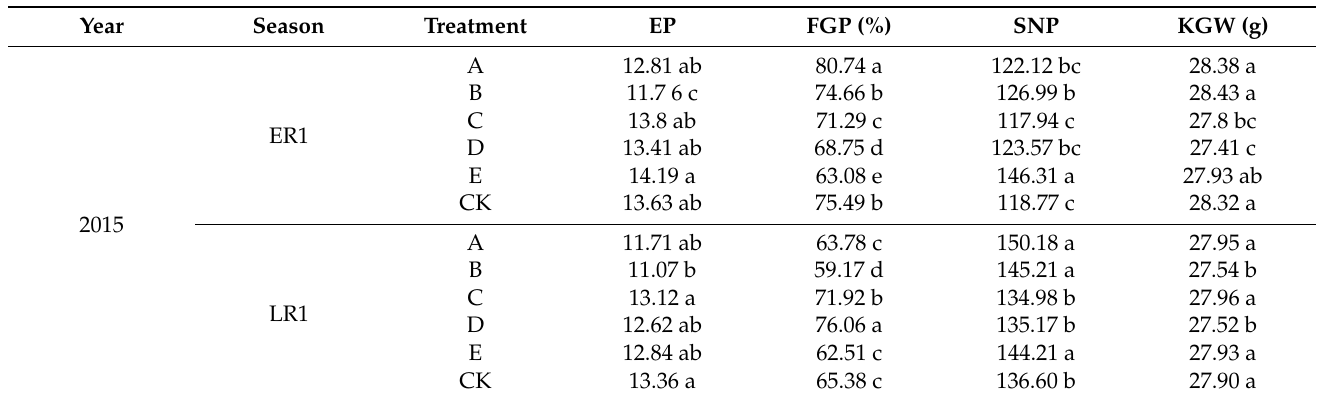
Table 4. Effect of different treatments on yield components in 2015 and